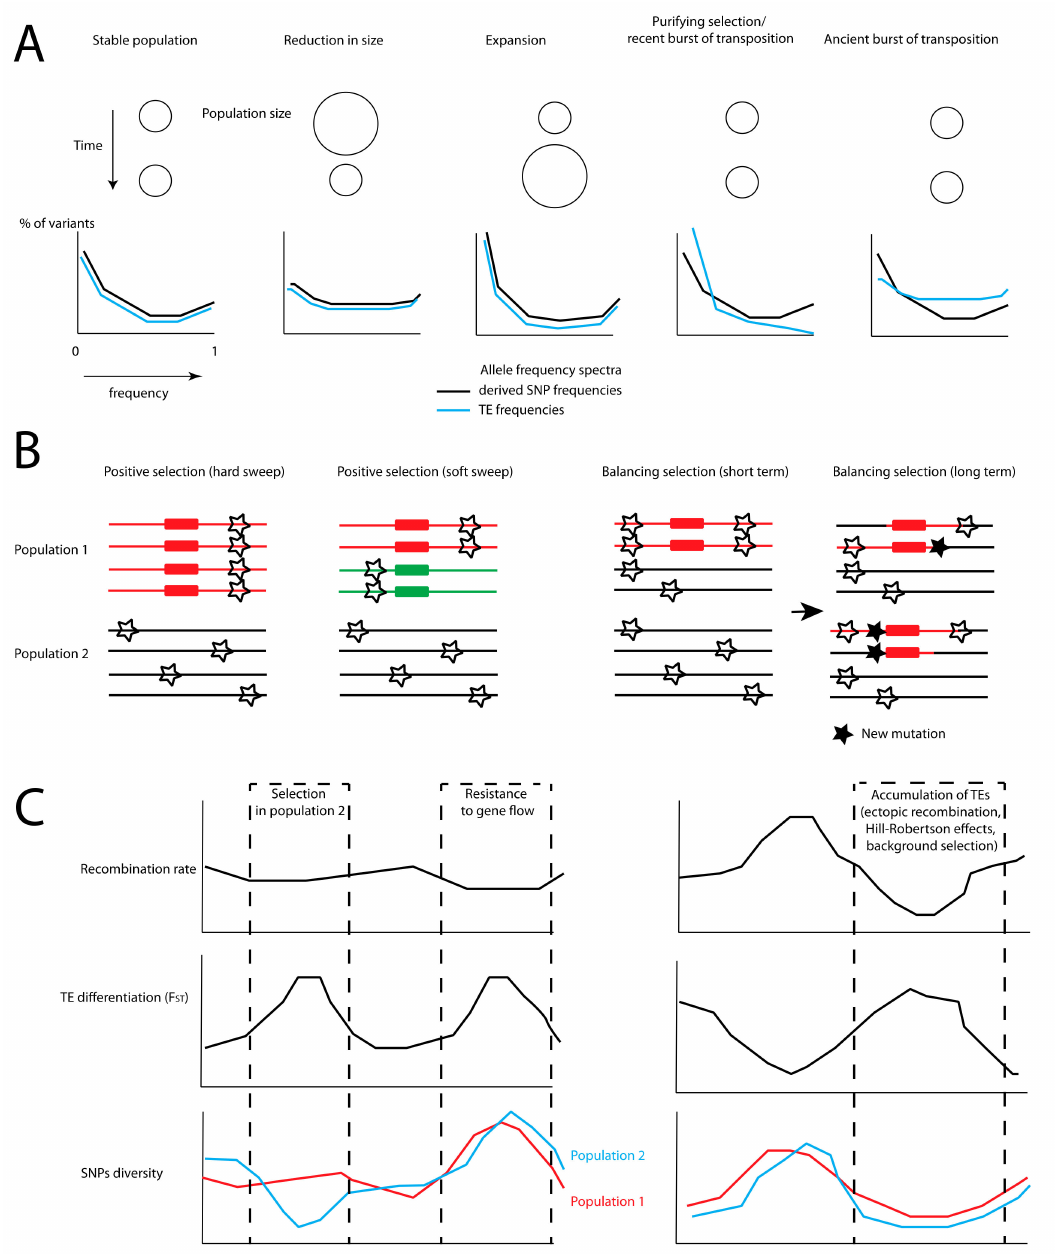
Figure 1. Summary of mechanisms impacting the diversity and frequency of transposable elements (TEs), and their impact on flanking sequences. ( A ) Demographic changes a ff ect the frequency spectra of both TEs and single nucleotide polymorphisms (SNPs) in a similar way, assuming neutrality and a constant rate of transposition. Reductions in e ff ective population sizes should lead to an excess of alleles at intermediate frequencies, while population expansions may lead to an excess of